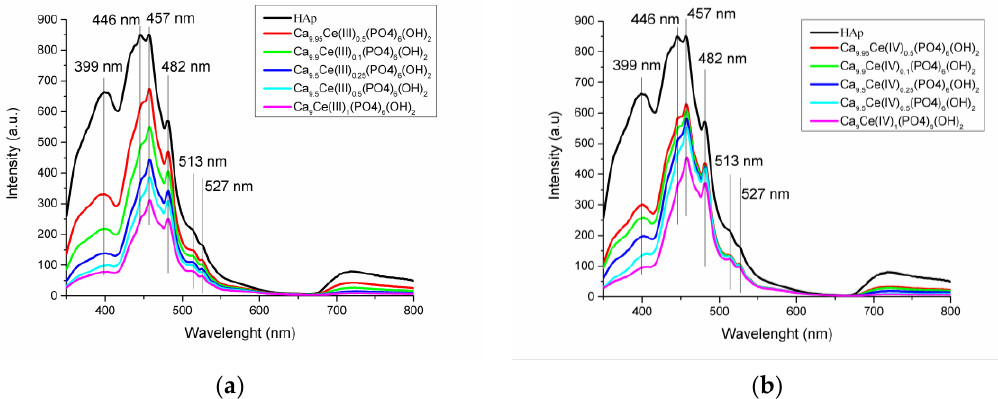
Figure 8. Room-temperature photoluminescence spectra of ( a ) Ca 10 − x Ce(III) x (PO 4 ) 6 (OH) 2 and ( b ) Ca 10 − x Ce(IV) x (PO 4 ) 6 (OH) 2 with different concentrations.